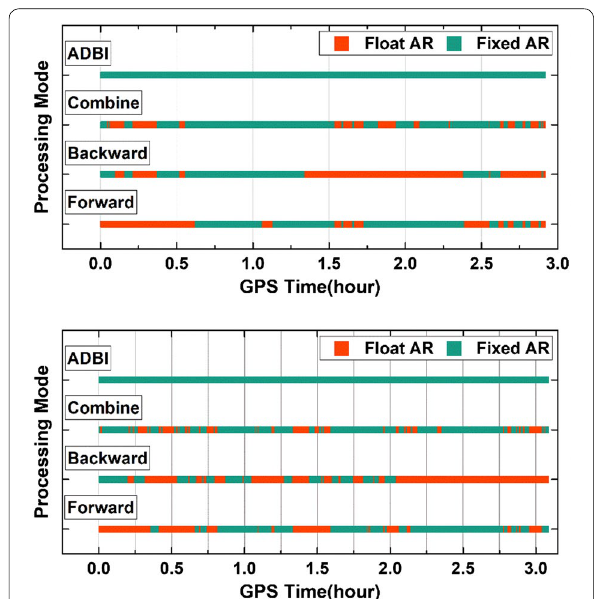
Fig. 9 Time series of ambiguity fixing rate with two-way filters, FBC method and ADBI strategy for airborne data (top) and vehicular data (bottom). The red points denote ambiguities float resolution and green is the ambiguity-fixed